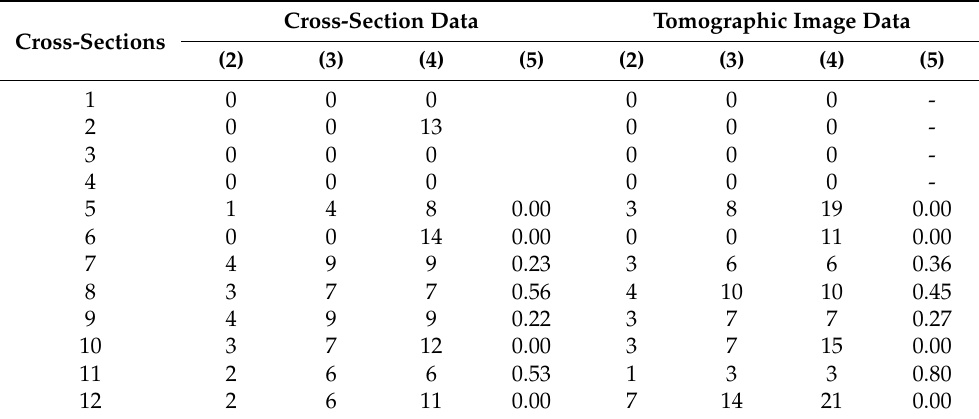
Table 3. Strength loss (SL in %) inferred by the equations of [34] (Equation (2)), [33] (Equation (3)); [35] (Equation (4)), and the ratio between the residual wall thickness and the trunk radius proposed by [36] (Equation (5)) using data from internal and open cavities and remaining wall thickness obtained from the cross-sections and in tomographic images.